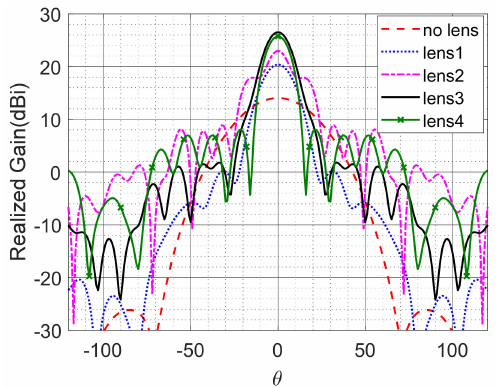
Figure 13. Radiation pattern of the horn antenna without and with flat